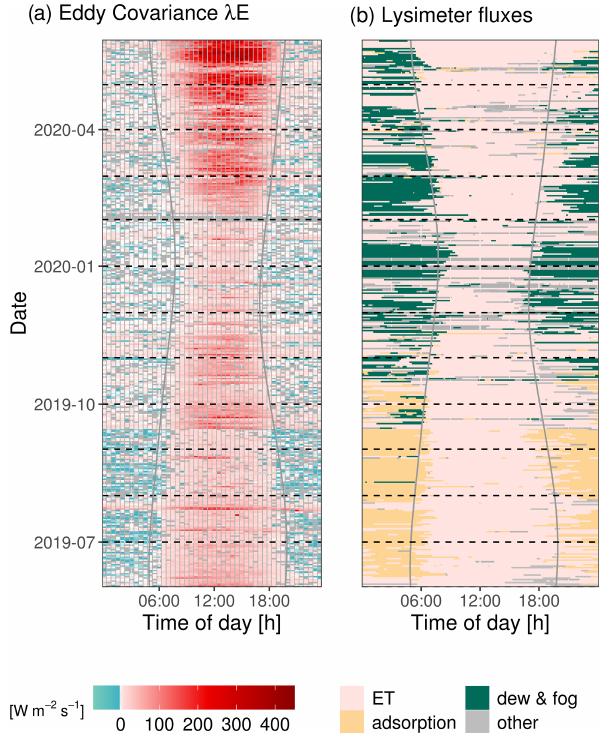
Figure 7. Diel and seasonal variation in (a) quality-filtered λE fluxes from EC and (b) assigned lysimeter fluxes. Solid curved vertical lines mark sunrise and sunset, respectively, as determined by the geographic coordinates of the field